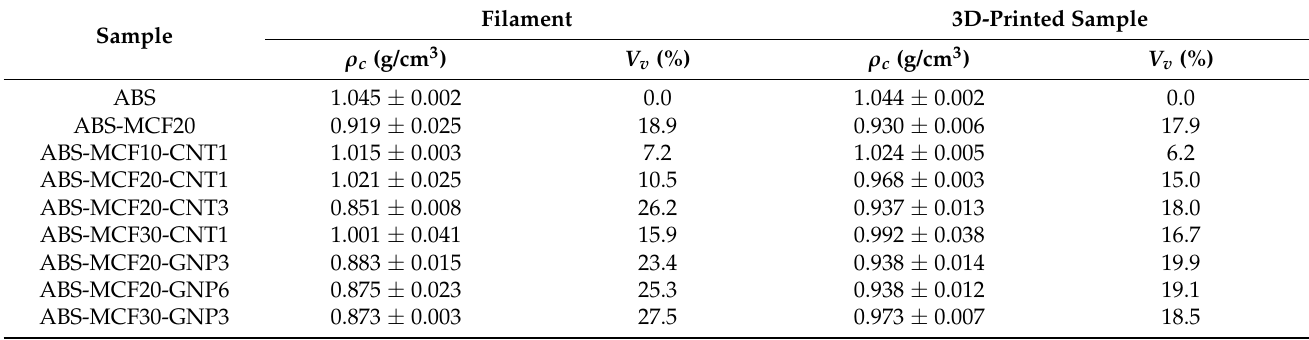
Table 6. The relative density and the volume of the void of filaments and 3D-printed